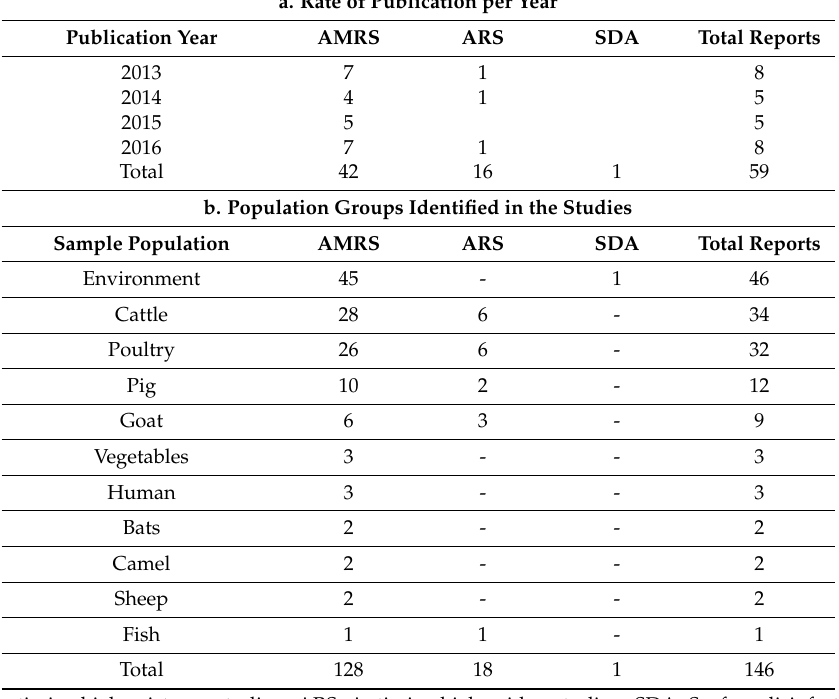
Table 2. Categorization for the measure of resistance or residue level.